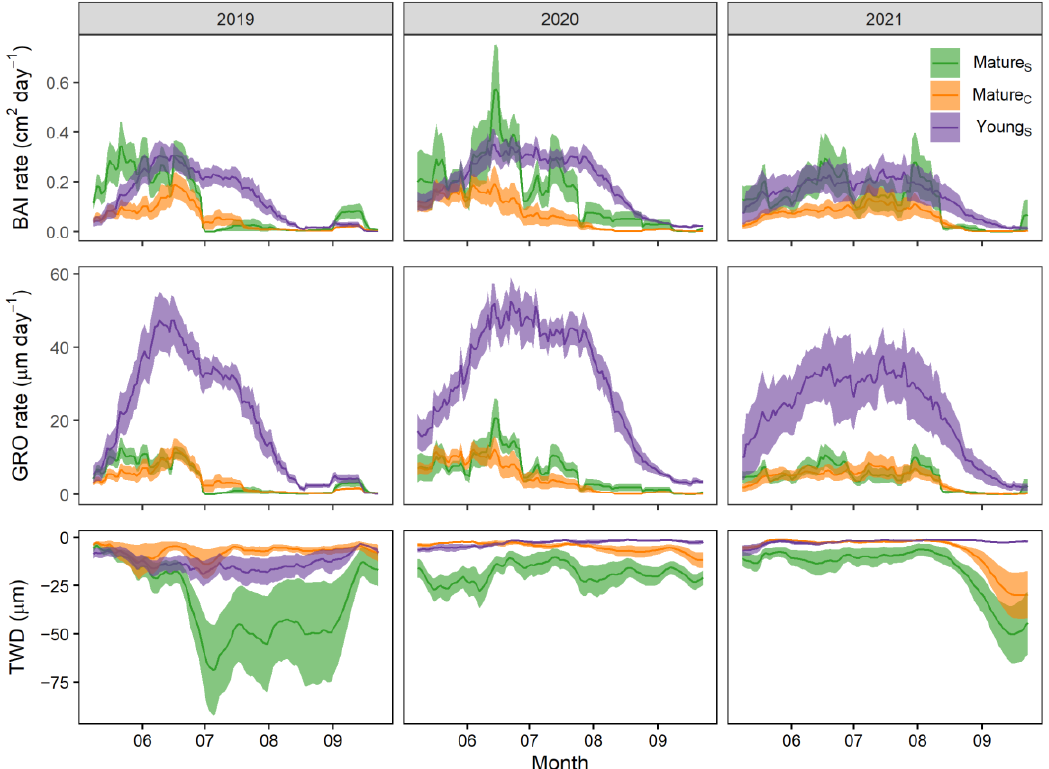
Figure 4. The average rate of the basal area increment (BAI), stem radius increment (GRO), and tree water deficit indicator (TWD) smoothed by a 14-day moving average and shown for the studied years 2019–2021. The abrupt cessations of the GRO rates of both mature tree groups are visible during the second half of the years. Colored area depicts standard errors.